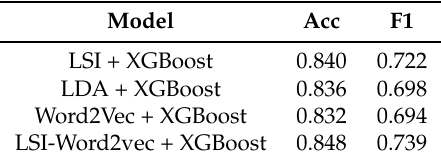
Table 3. Comparison of the results of different feature extraction methods. LDA, Latent Dirichlet Allocation.